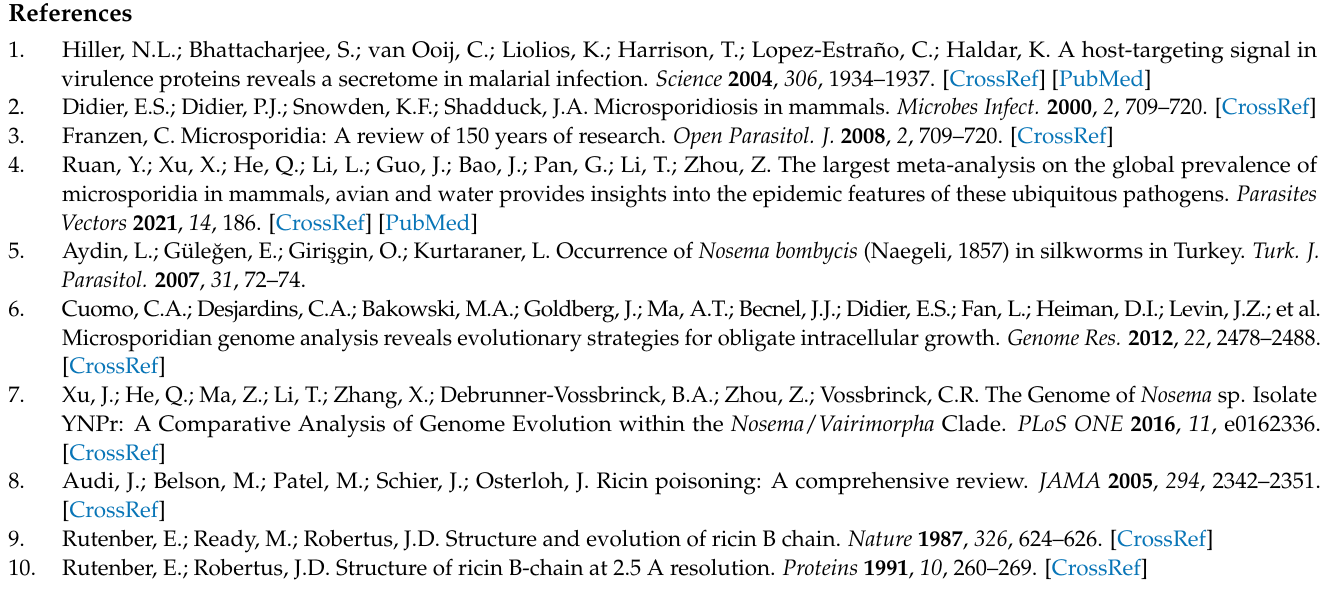
subfamily 2; Figure S2: Multiple sequence alignment of NbRBL subfamily 3; Figure S3: Multiple sequence alignment of NbRBL subfamily 4; Table S1: Data of NbRBLs in the B. mori embryo